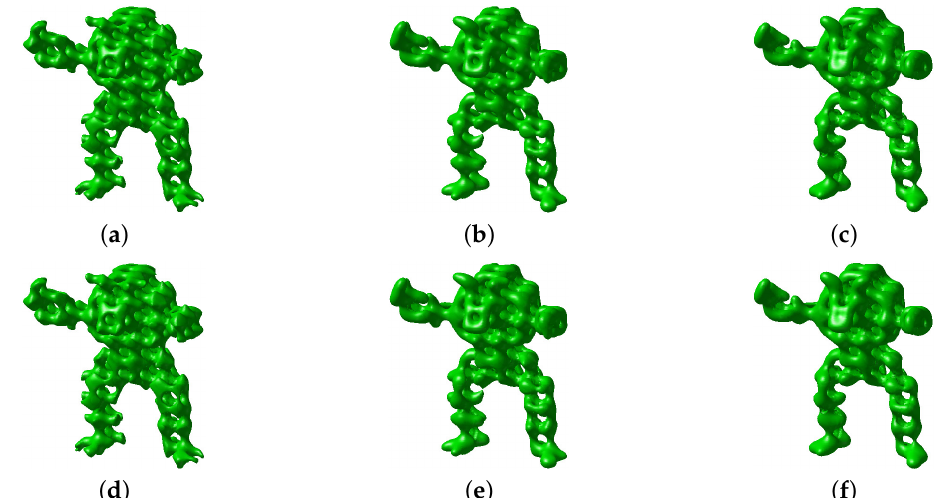
Figure 21. ( a – c ) are snapshots of phase separation on the Stanford Armadillo at t = 40 ∆ t , 120 ∆ t , and 160 ∆ t , respectively. ( d – f ) are snapshots of phase separation with replacing initial values inside the object at t = 40 ∆ t , 120 ∆ t , and 160 ∆ t , respectively. Here, the local average concentration function Equation (13) is